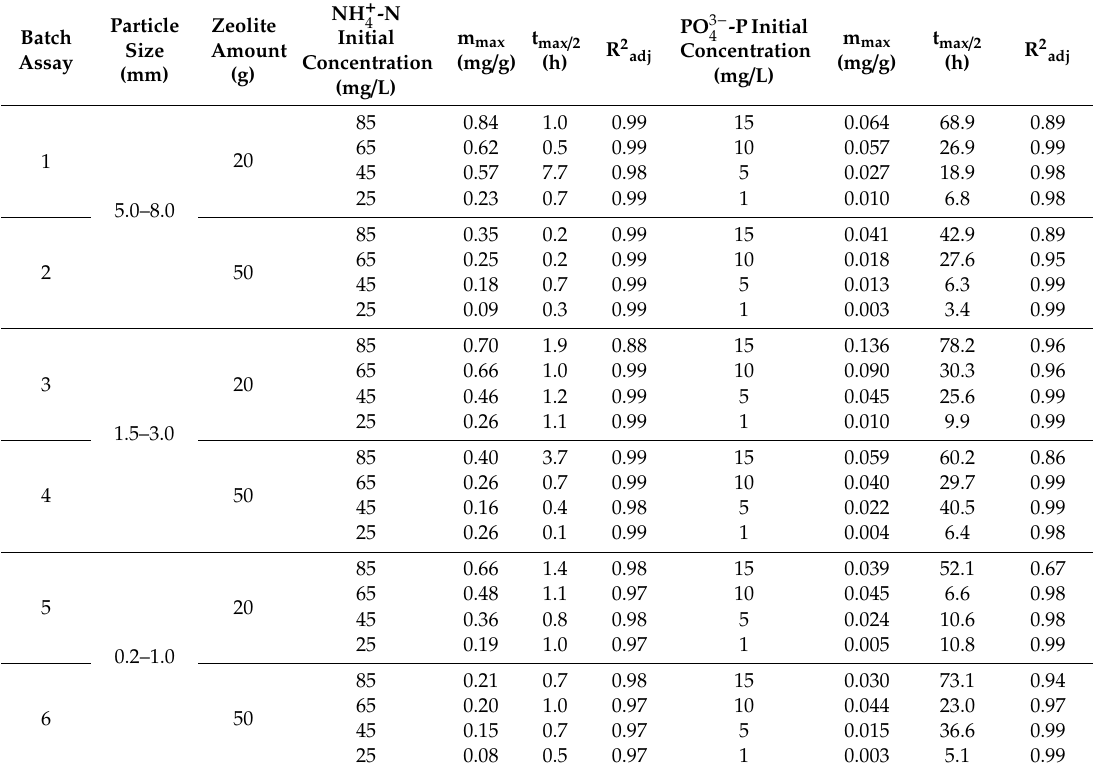
Table 5. Saturation-growth-rate parameters for NH 4 + -N and PO 4 − 3 -P adsorption onto zeolite. Batch